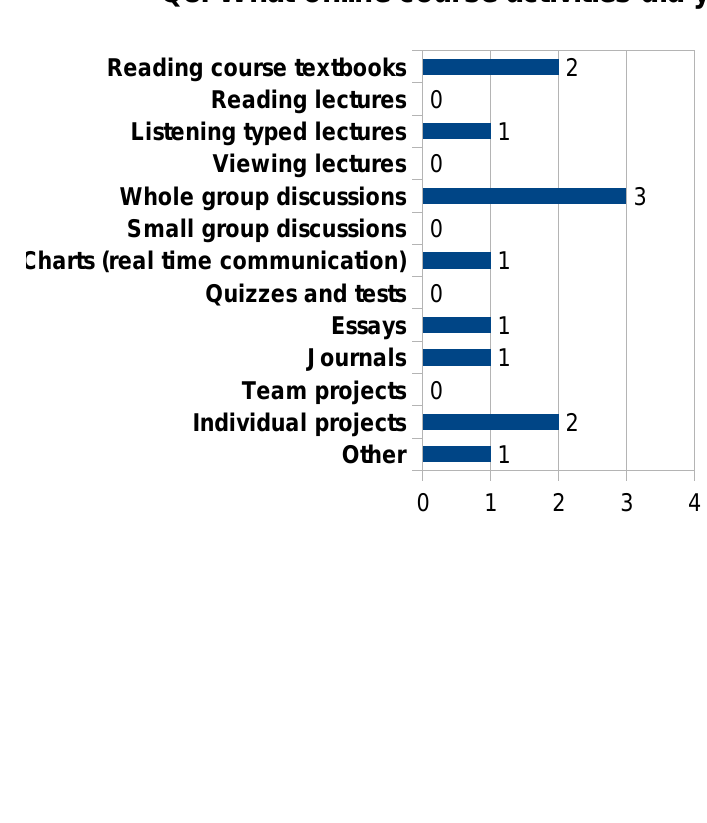
1 Bars represent the number of respondents who selected a particular answer